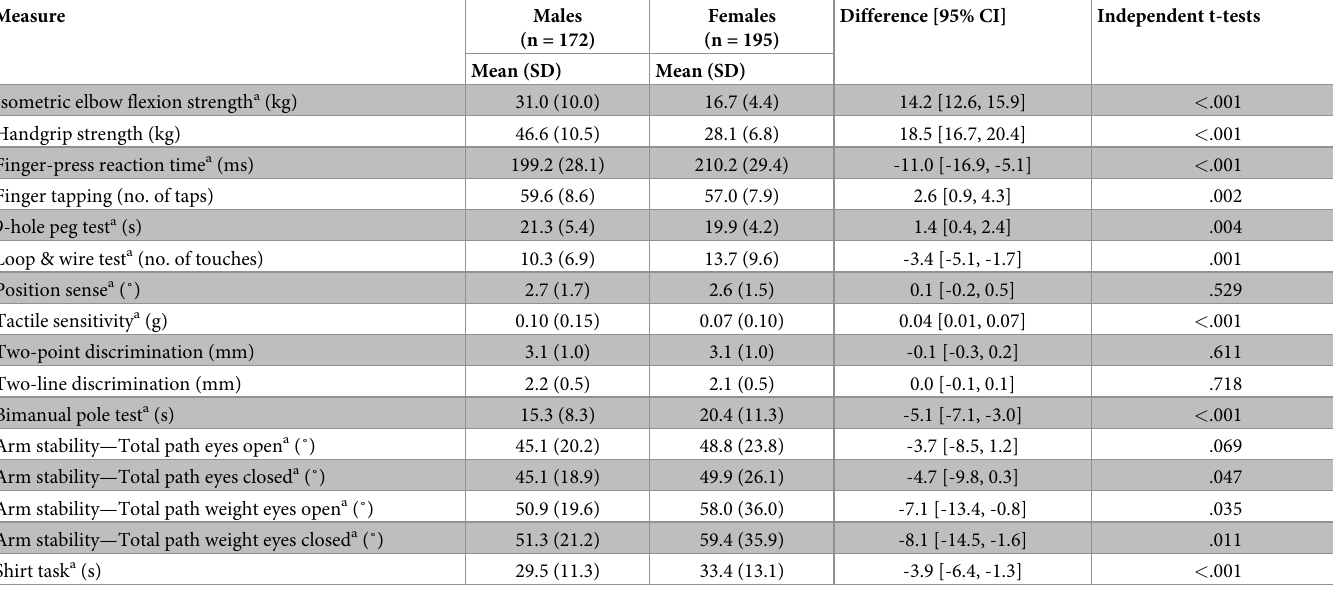
(n = 172) Mean (SD) Mean (SD)